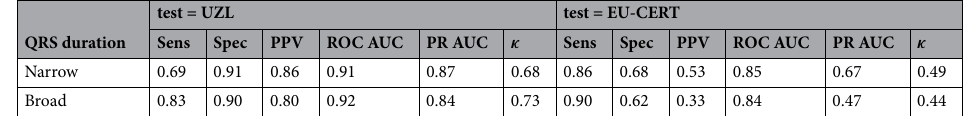
Table 7. Results for the combined model in test1 UZL and EU-CERT broken down by QRS duration.